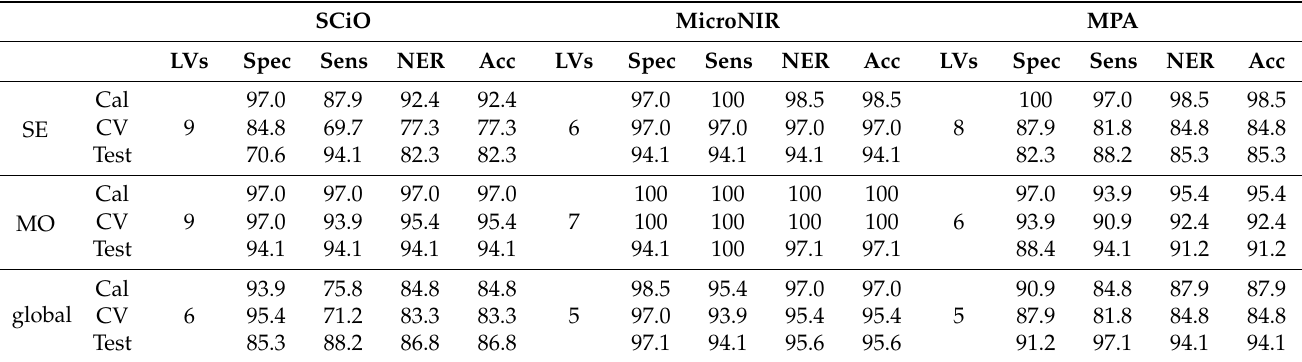
Table 2. Classification results: fresh/thawed cuttlefishes (SE) and musky octopuses (MO). All values are expressed in